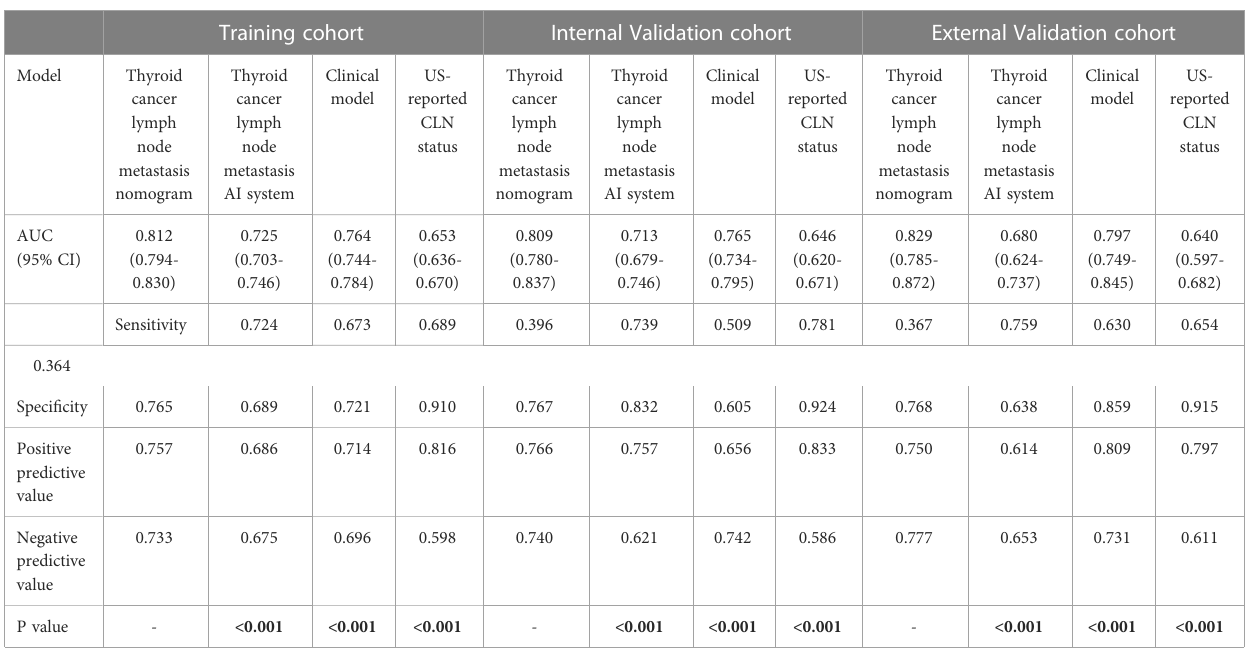
TABLE 3 Identi fi cation performance of thyroid cancer lymph node metastasis nomogram, thyroid cancer lymph node metastasis AI system, clinical model and US-reported CLN status in the training cohort, internal validation cohort and external validation cohort.